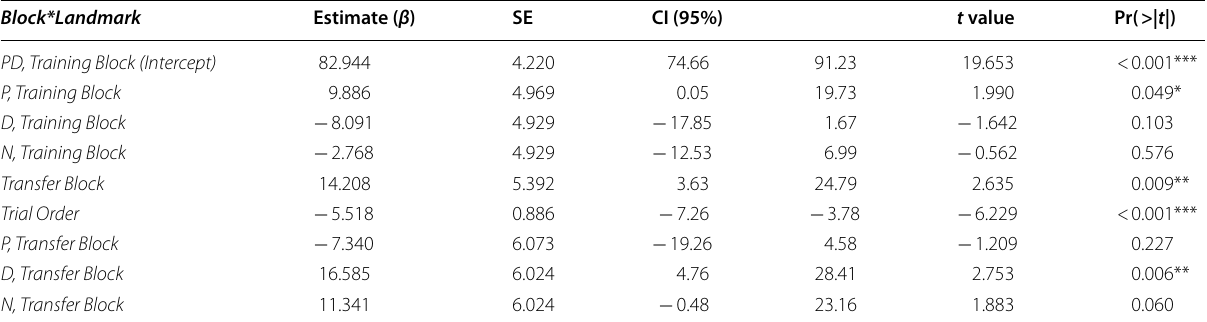
Asterisks “***”, “**”, and “*” denote p < .001, p < .01, p < .05, respectively